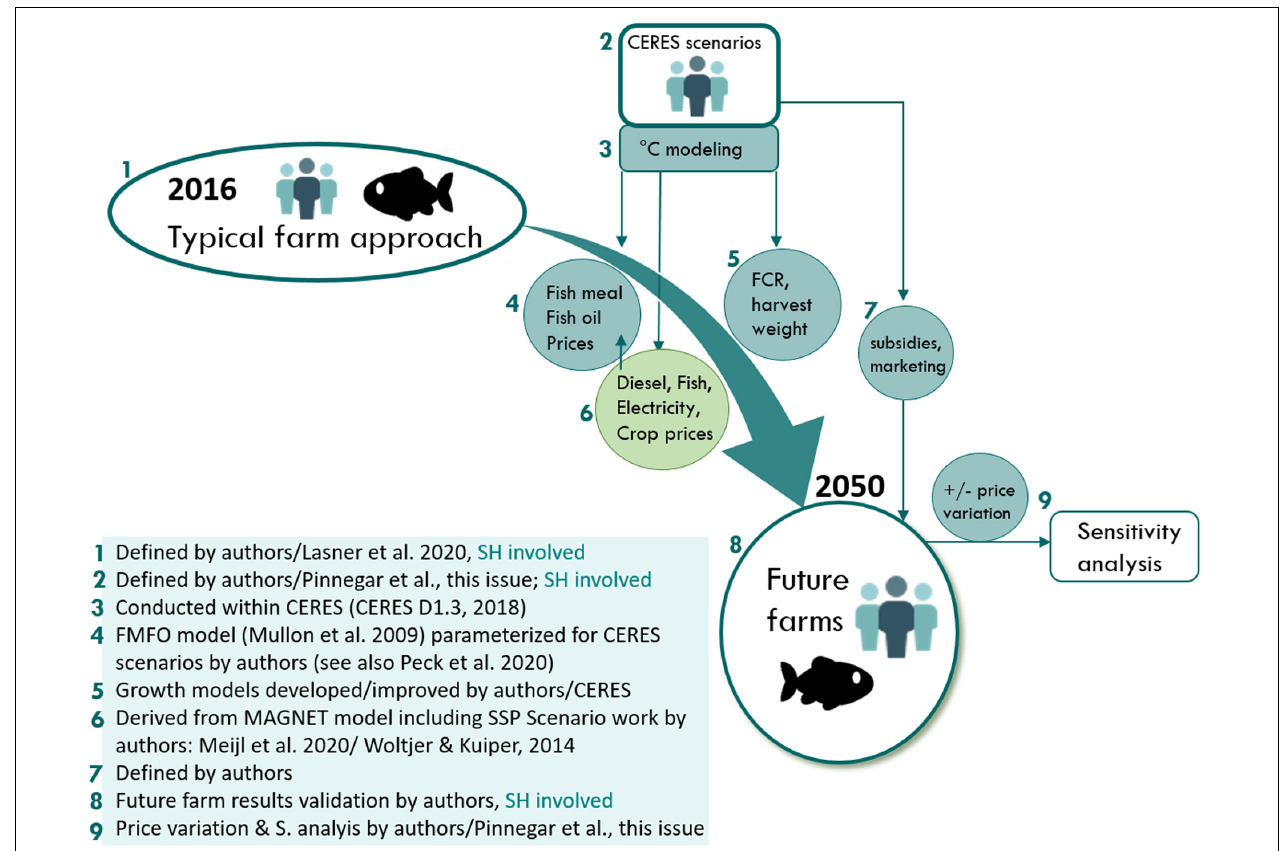
FIGURE 2 | Dataflow and models involved in the application of climate change and European aquatic resources (CERES) aquaculture scenarios. Stakeholder (SH) engagement within different steps is indicated as “SH” and by related icon. FCR, feed conversion ratio; S. analysis, sensitivity